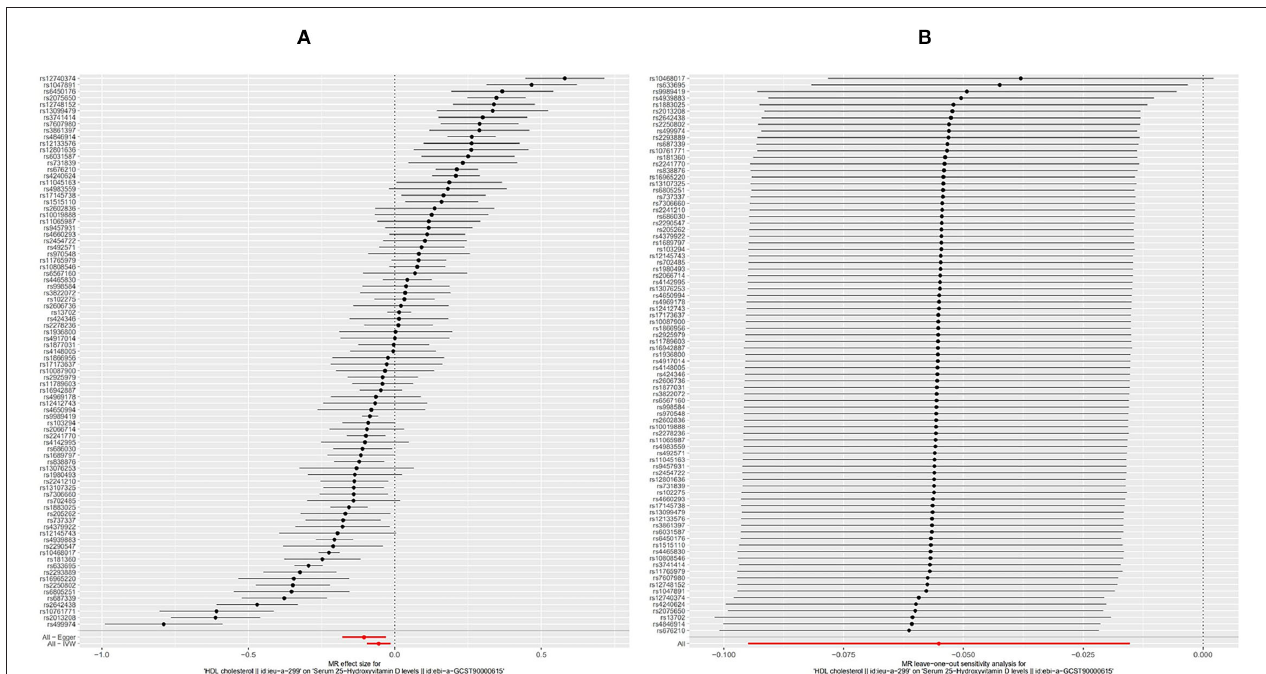
FIGURE 5 | Forest plot of included SNPs in the mendelian randomization analysis for casual effect of HDL on vitamin D deficiency. (A) Meta-analysis of SNPs’ effects on vitamin D deficiency based on inverse variance weighted (IVW) method with random effect model. (B) Sensitivity analysis by omitting every SNP. LDL, High-density